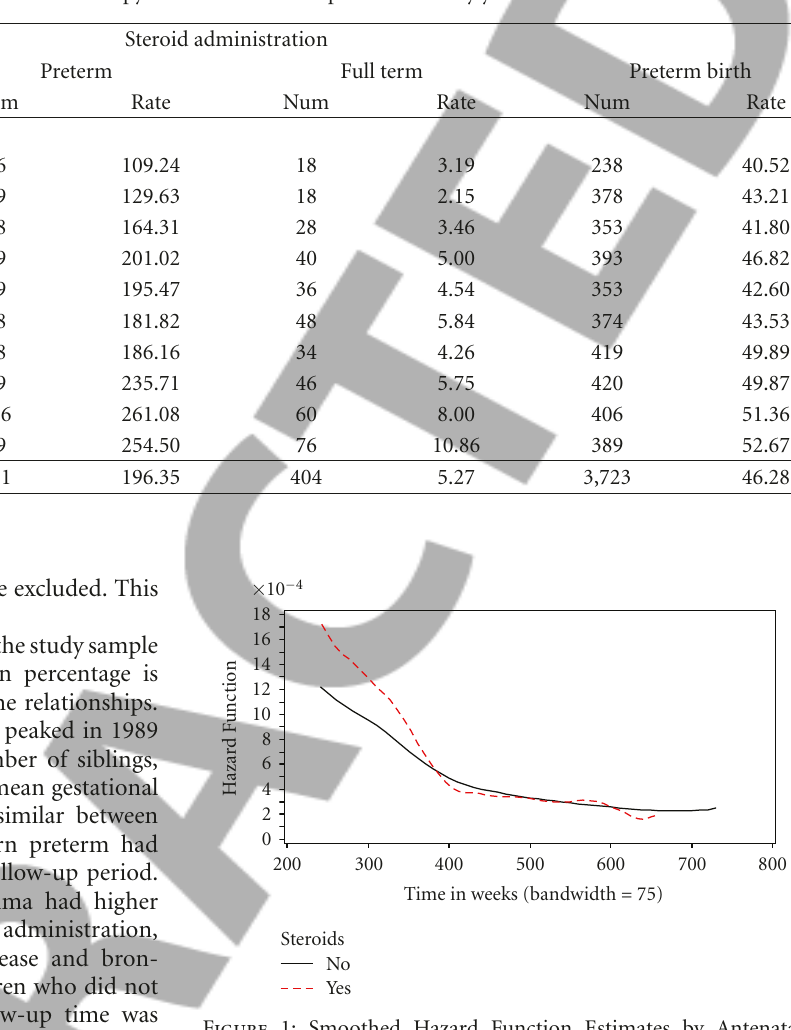
Figure 1: Smoothed Hazard Function Estimates by Antenatal Steroid Therapy. Note: Adjusted for gender, gestational age and year of